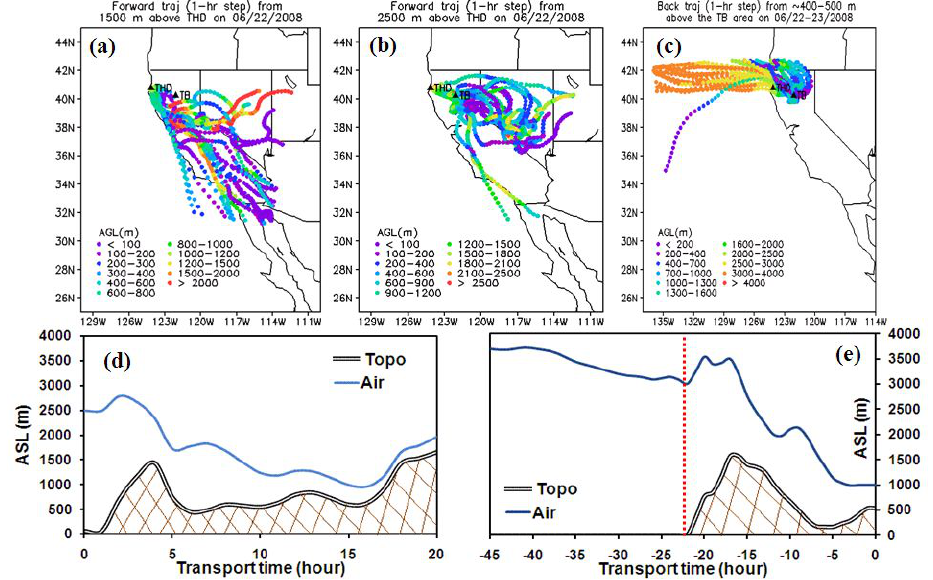
Fig. 10. Forward trajectories originating on 22 June from (a) 1500m (b) 2500m above THD; (c) back trajectories originating from 400– 500m above TB area; transport height as a function of time along with topography along the (d) forward trajectory originating from 2500m above THD, 22 June 01:00UTC (e) back trajectory originating at 400–500m above TB area, 23 June 00:00UTC Fig. 11. Forward trajectories originating on 20 June from (a) 1500m (b) 2500m above THD; (c) Back trajectories originating from 400–500m above TB